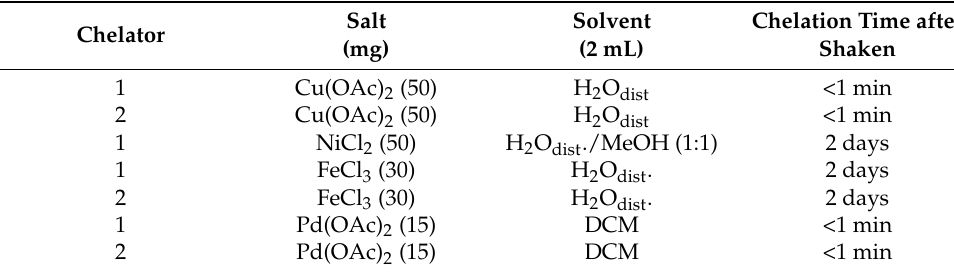
Table 4. Chelation experiments for different